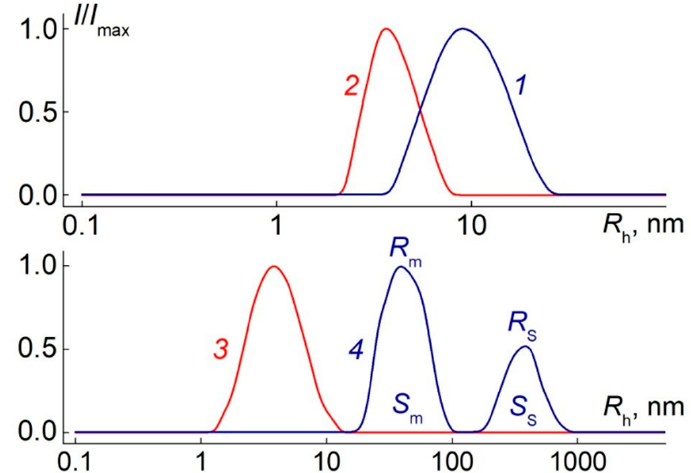
Figure 2. The dependences of relative intensity I / I max of scattered light on the hydrodynamic radius R h of scattering species for solutions of APE-g-PiPrOx at c = 0.0073 g · cm − 3 ( 1 ) and PiPrOx-m at c = 0.0357 g · cm − 3 ( 2 ) in nitropropane; for solutions of PiPrOx-m at c = 0.0020 g · cm − 3 ( 3 ) and APE-g-PiPrOx at c = 0.00010 g·cm − 3 ( 4 ) in water. I max is the maximum value of light scattering intensity I for given solution concentration; explanations for R m , R s , S m , and S s see below in Section 3.3.